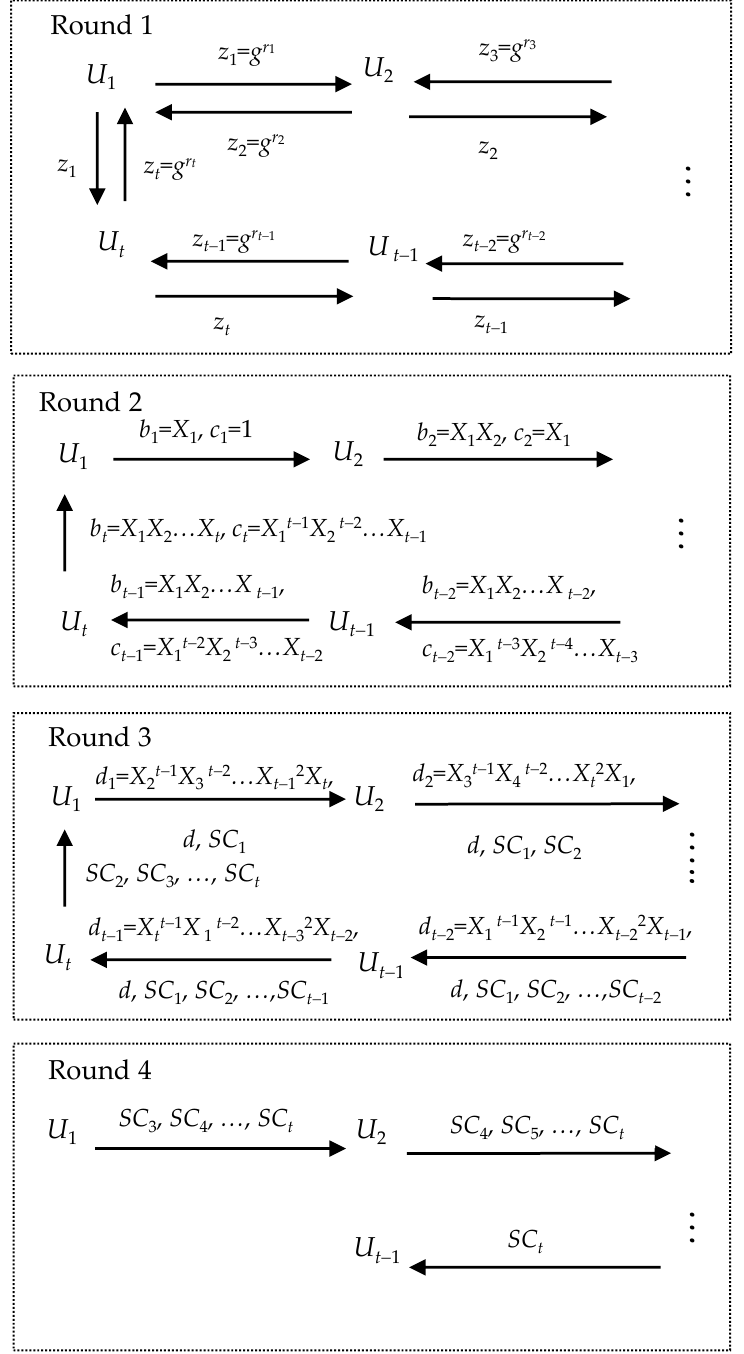
Figure 5. Improvement on cyclic protocol.